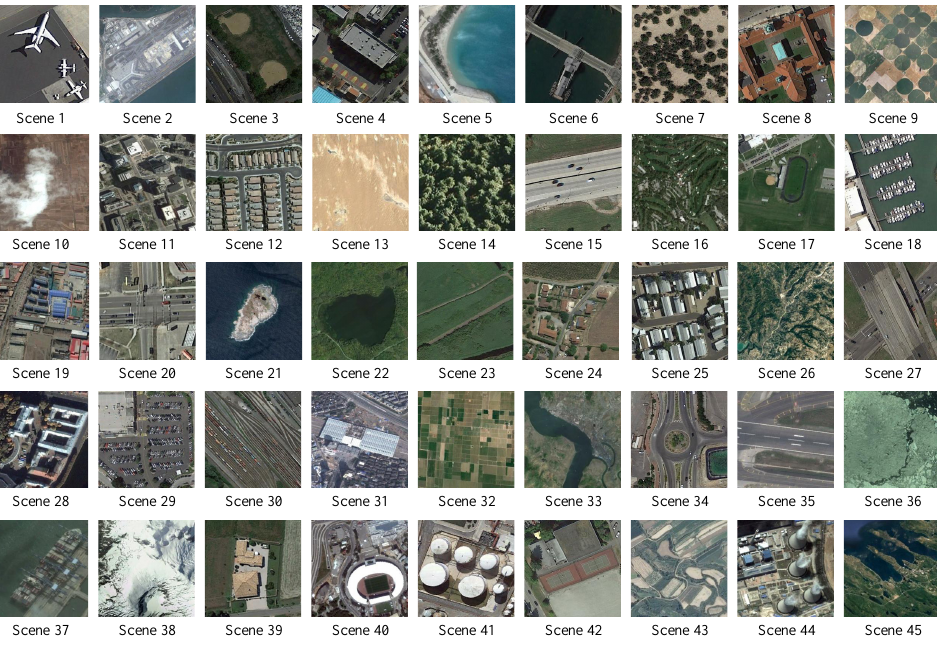
Figure 7. Examples of different scenes in NWPU dataset. The names of scenes can be found in Table